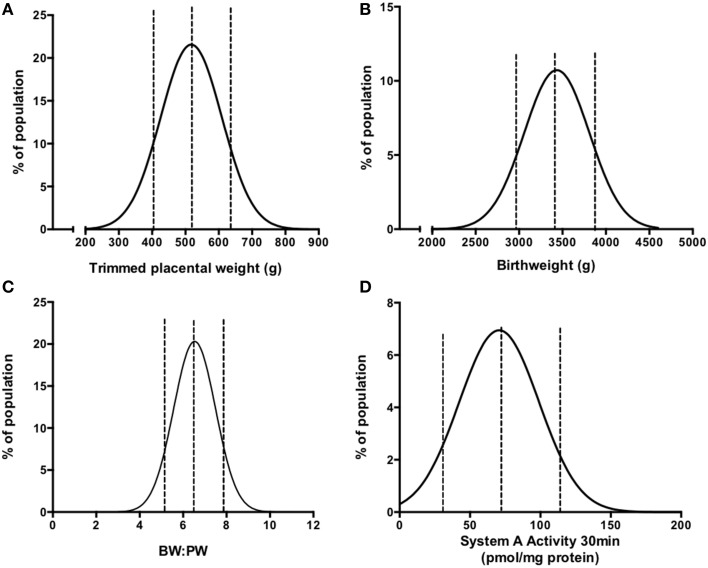
Frequency (%) distributions for trimmed placental weight (A), birthweight (B), BW:PW ratio (C), and placental system A activity (D) in an AGA population following collation of previously published data (Ditchfield et al., 2010, 2015; Hayward et al., 2012, 2013; Brereton et al., 2013; Coleman et al., 2013; Lean et al., 2014; Jones et al., 2015; Mills et al., 2015). Dotted lines denote the 10th, 50th, and 90th centile. Actual values are as follows (10th, 50th, 90th centile); For (A) 408, 520, and 642 g; (B) 2964, 3430, and 3896 g; (C) 5.2, 6.6, 7.5; (D) 33.2, 74.4, 115.6 pmol/mg protein. R2-values of best fit to Gaussian distribution were as follows (A) 0.989, (B) 0.903, (C) 0.990, (D) 0.893. N = 210 for (A–C) and N = 60 for (D).